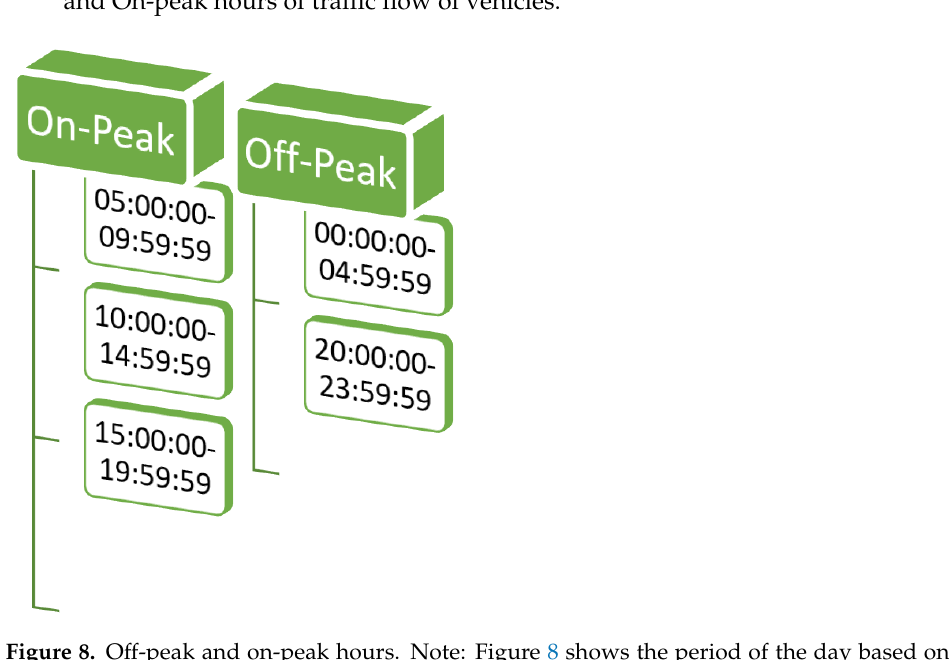
Figure 8. Off-peak and on-peak hours. Note: Figure 8 shows the period of the day based on the on-peak and off-peak hours.